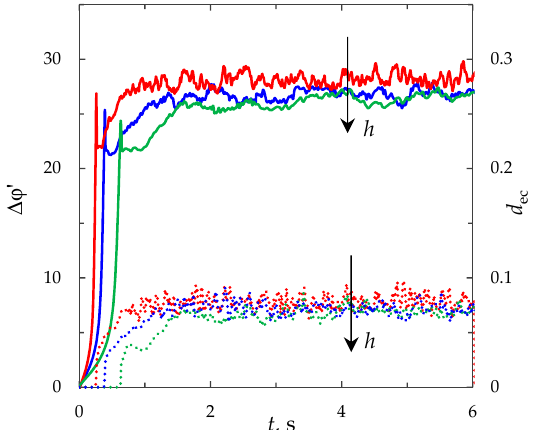
Figure 12. ChP (solid lines) and the average thickness of the electroconvective mixing layer, d ec (dotted lines). The results of computation for h = 0.25 × 10 − 3 m (red lines), 0.5 × 10 − 3 m (blue lines), 10 − 3 m (green lines) at current density i av / i lim = 2.